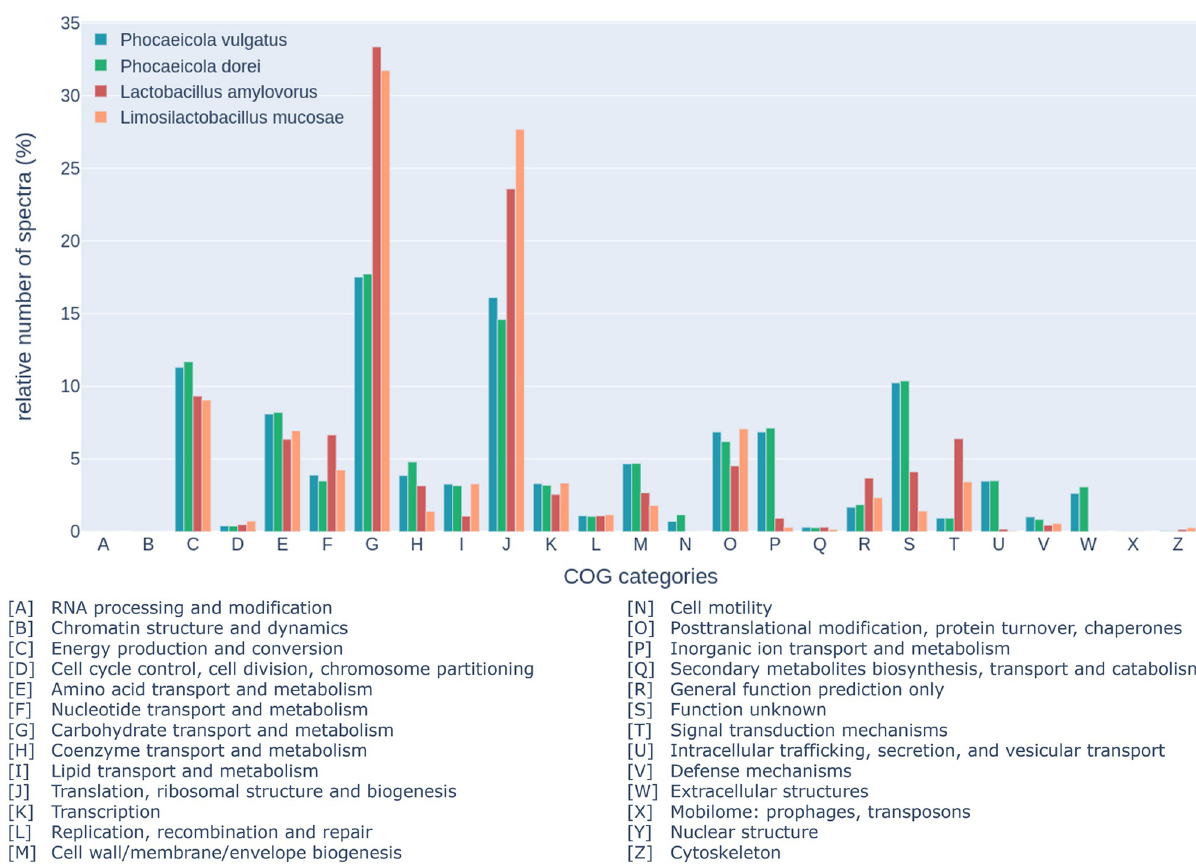
Fig 3. Barplot summarizing the relative abundances of the COG functional categories of the two generalist (blue/green) and two specialist (red/ orange) highly abundant genomes.